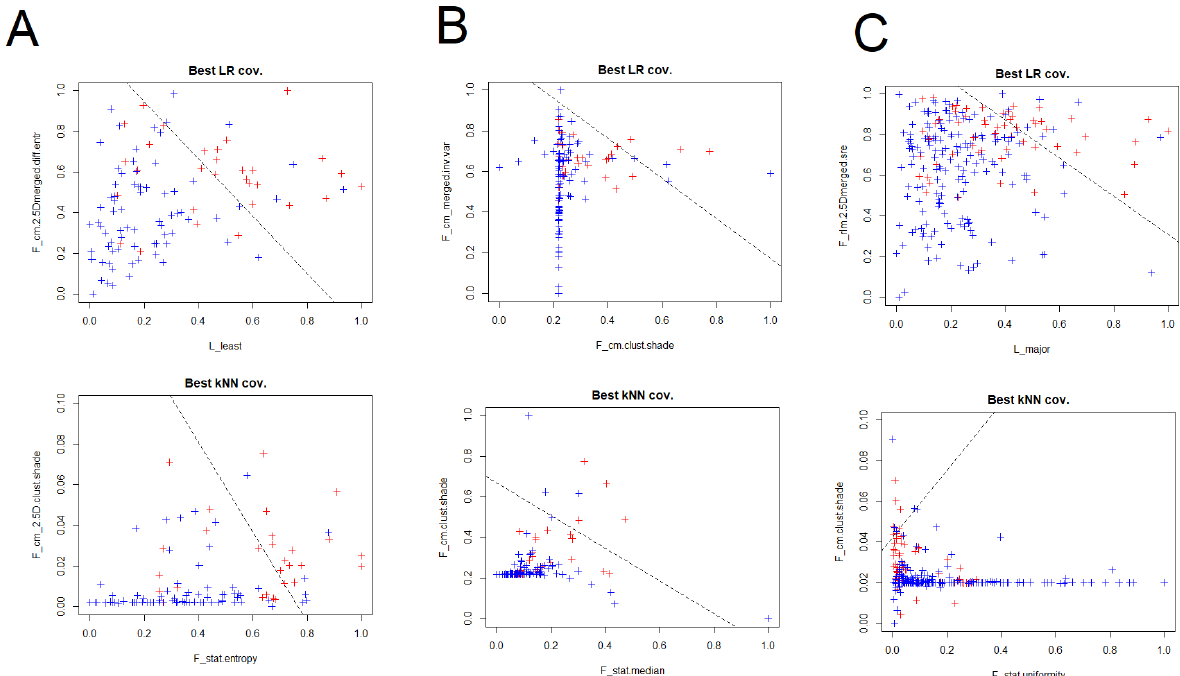
Figure 2. Visual representation with the couples of RaF with best performances at LR and k-nearest neighbors (kNN) analyses for scanner 1 ( A ), scanner 2 ( B ) and both the scanner considered together ( C ).